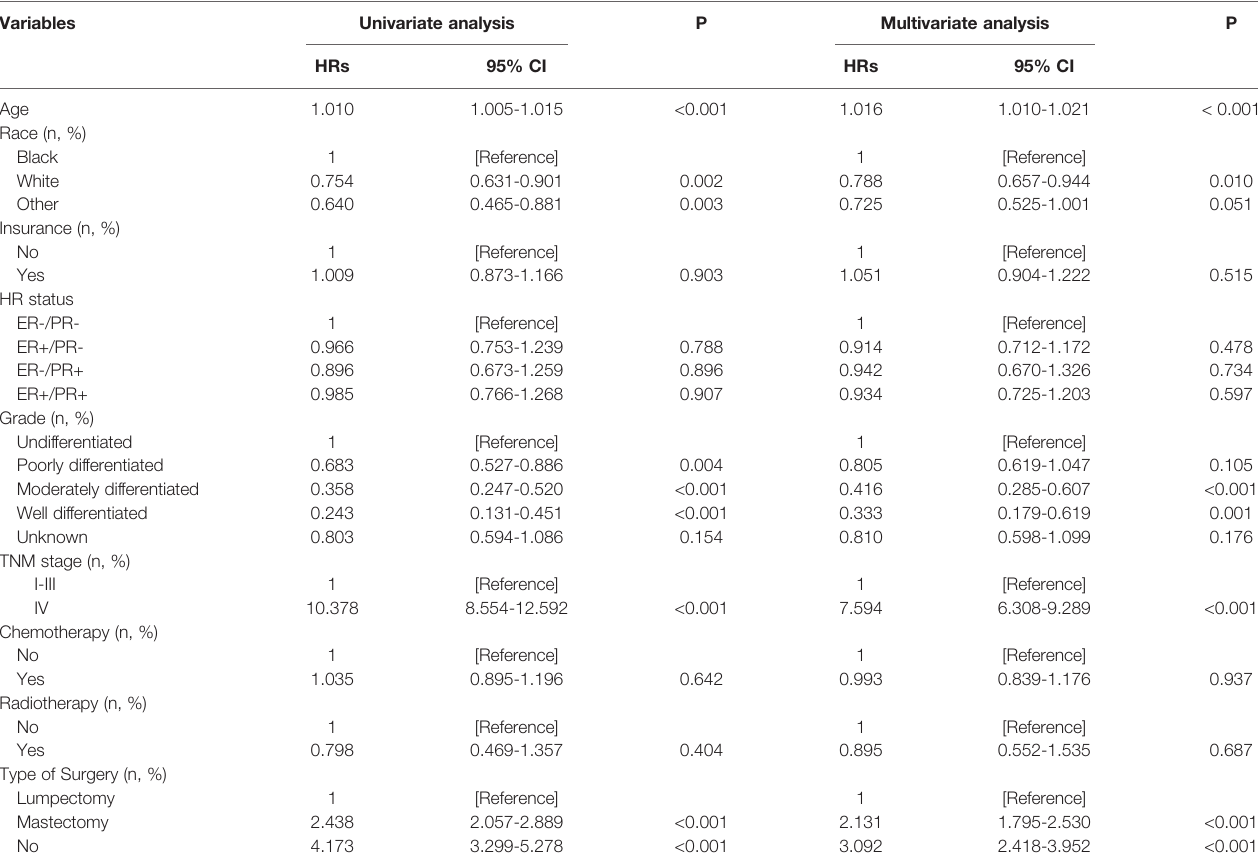
TABLE 2 | Prognostic factors for BCSS in our study cohort.